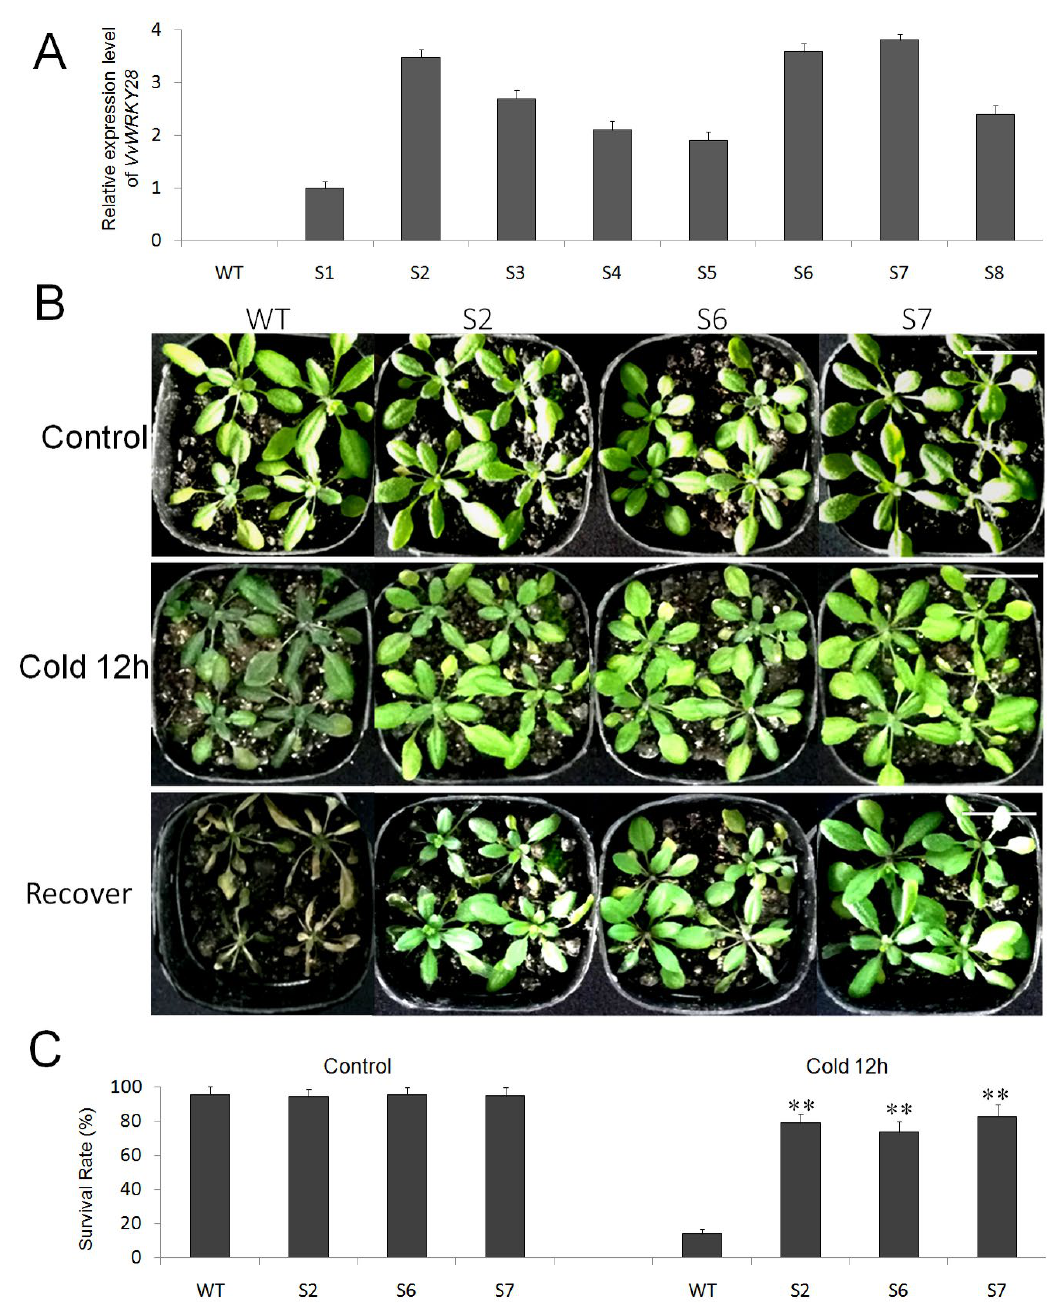
Figure 4. The overexpression of VvWRKY28 improved the cold tolerance of Arabidopsis . ( A ) qRT-PCR results of the expression levels of VvWRKY28 in WT and transgenic lines (S2, S6, S7). ( B ) The phenotype of WT and transgenic plants after low temperature stress and recovery. The ruler stood for 3 cm. ( C ) Survival rates of WT and transgenic lines under normal and low temperature conditions. t -test showed that under cold stress, there was a very significant difference between transgenic lines and WT, ** p ≤0 .01.